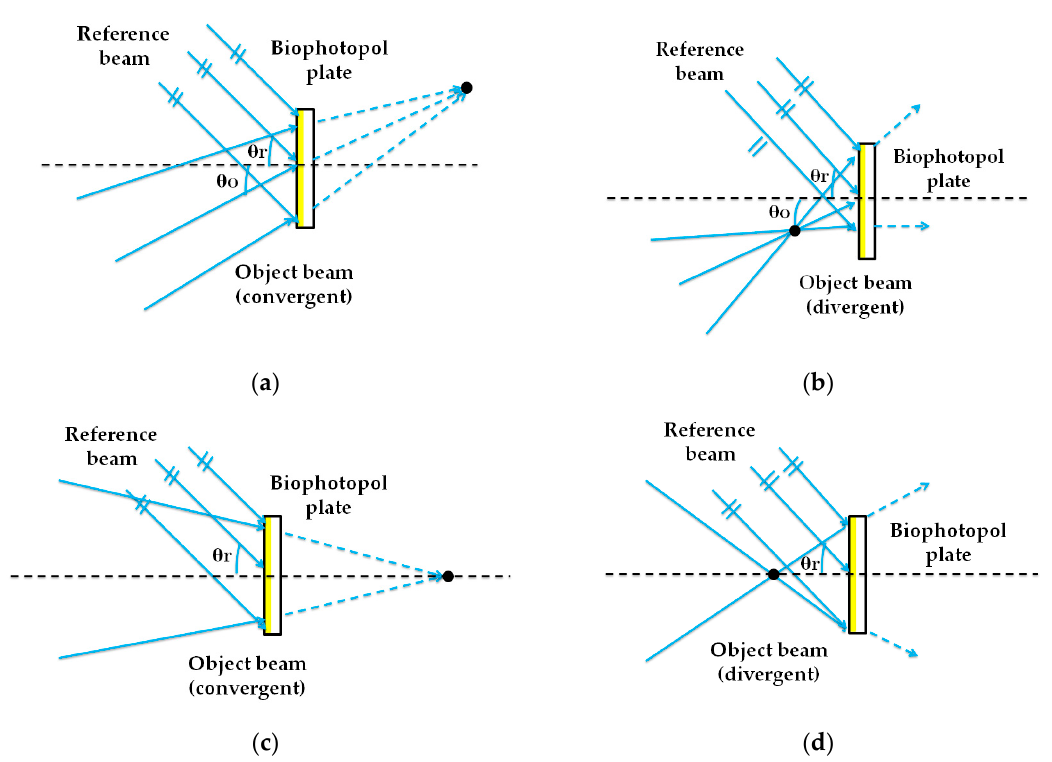
Figure 1. Holographic storage recording process (488 nm) with symmetric ( a ) and ( b ), and asymmetric ( c ) and ( d ) recording beams; and with positive ( a ) and ( c ), and negative ( b ) and ( d ) focal points.